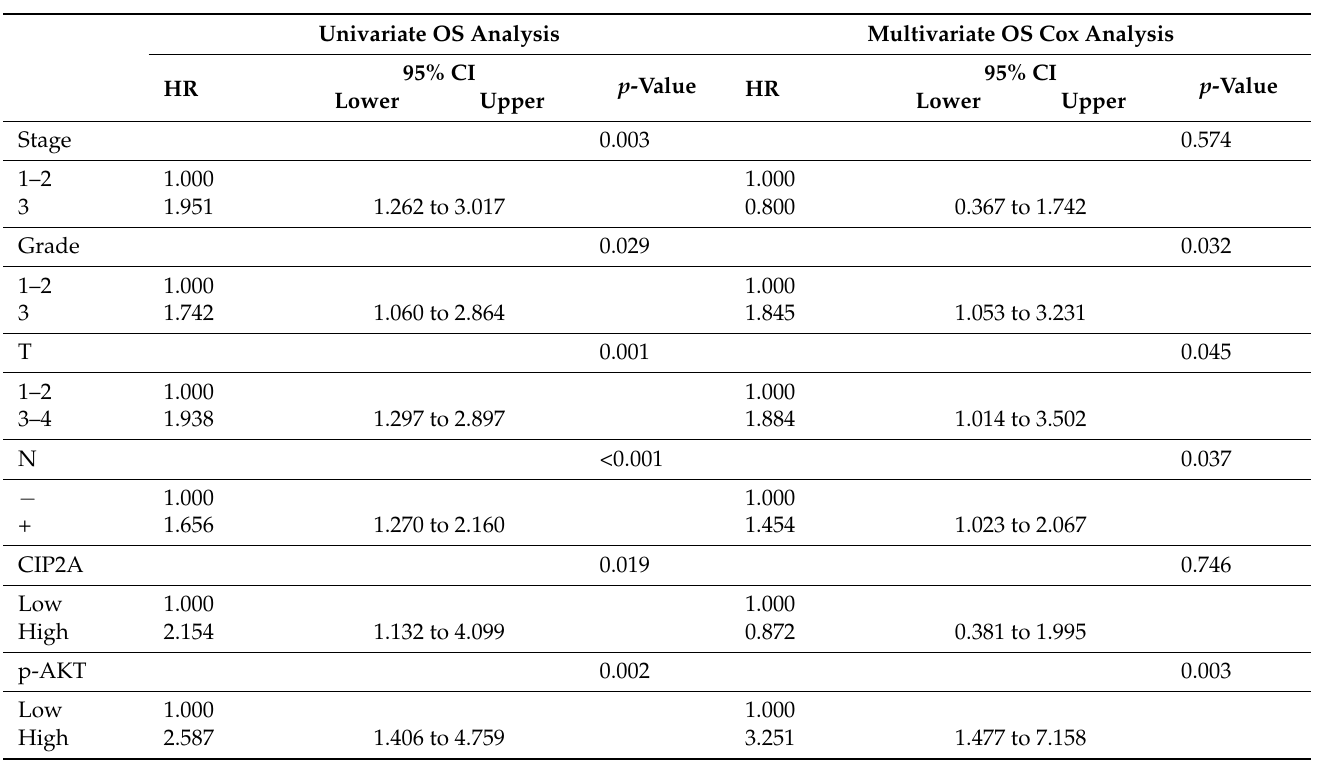
Table 2. Univariate and multivariate Cox analyses in the cohort of 220 patients with early breast